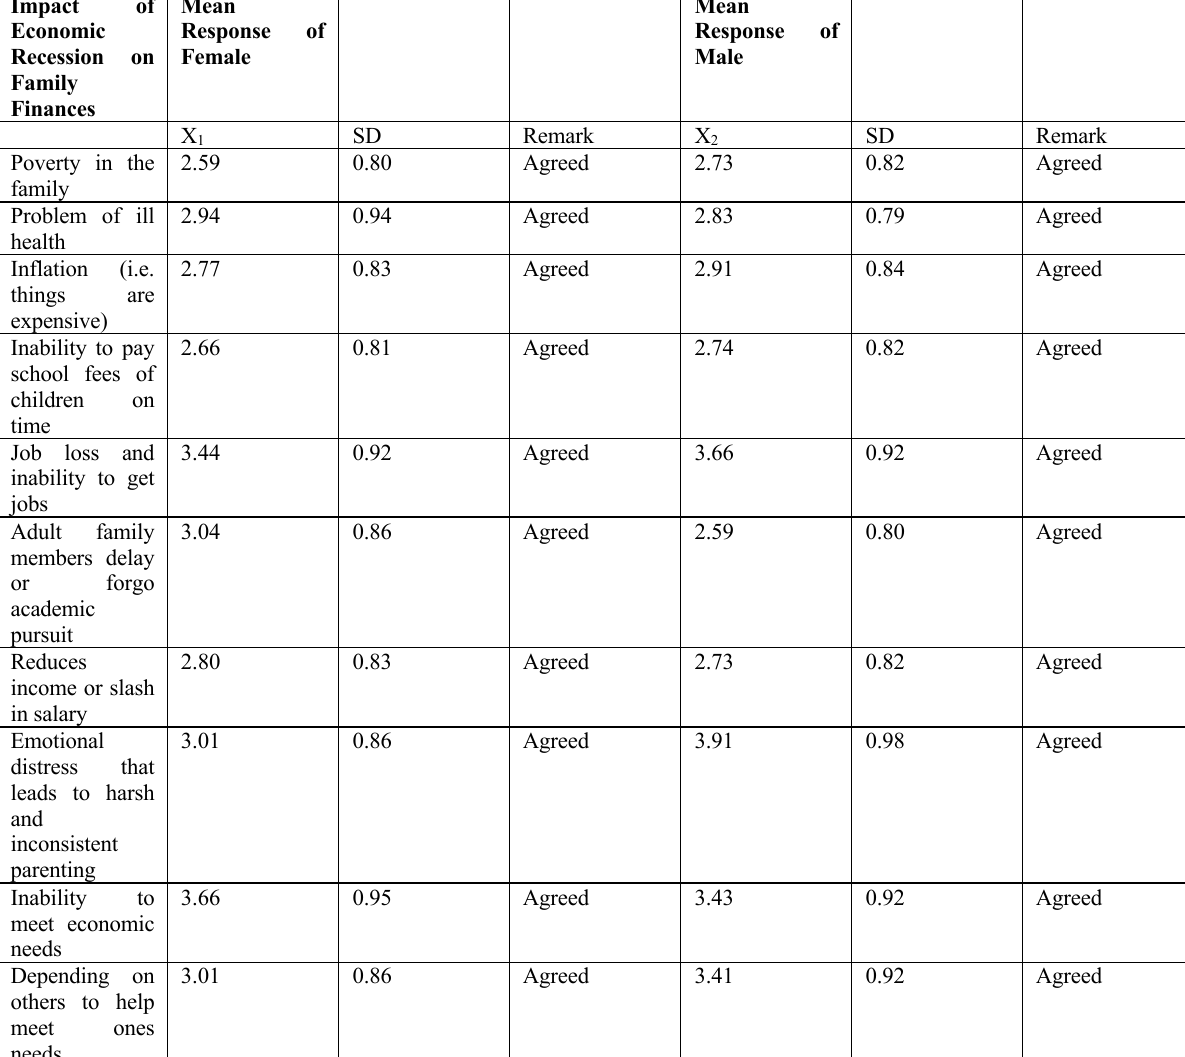
Table 3: Mean Response on Impact of Economic Recession on Family Financial Resources